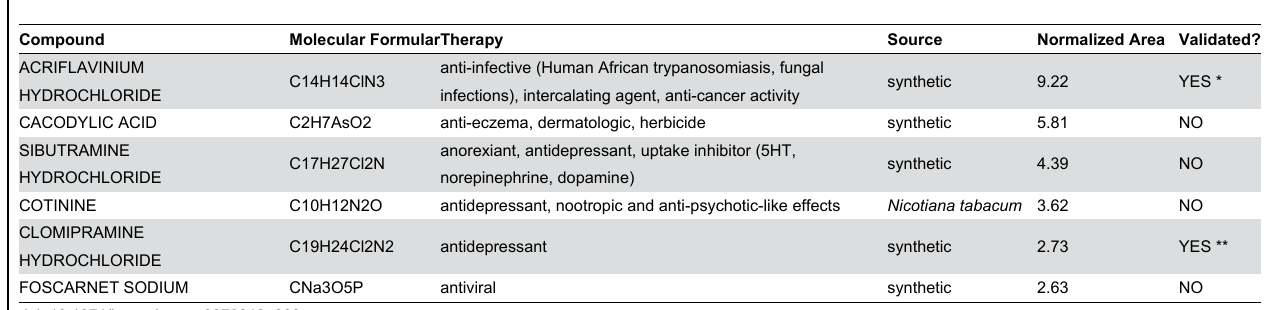
Table 3. NINDS Screen - Positive Hits.